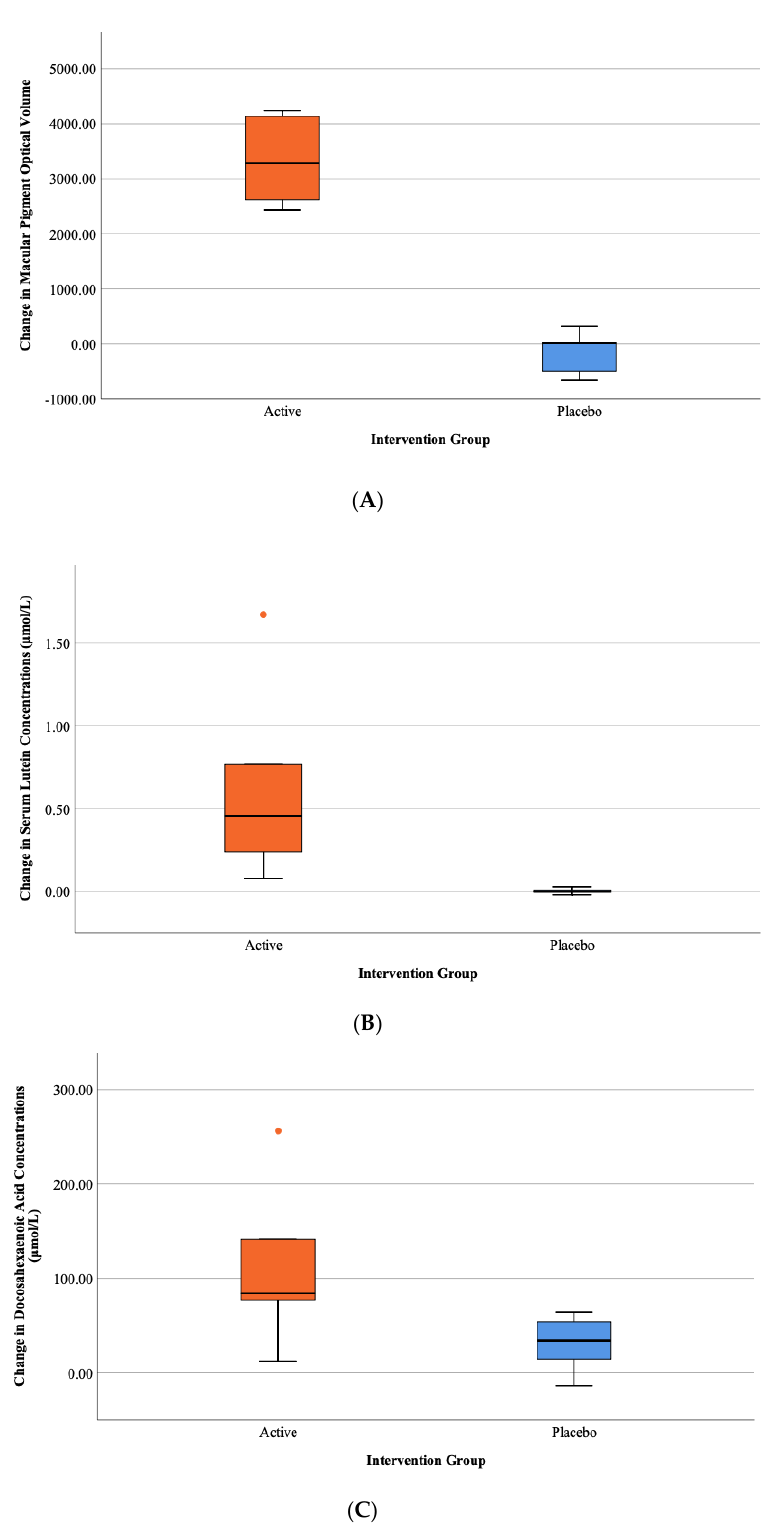
Figure 2. ( A ) Box plots illustrating change in MPOV over 12 months for active and placebo intervention groups. ( B ) Box plot illustrating change in serum lutein over 12 months for active and placebo intervention groups. ( C ) Box plot illustrating change in plasma DHA over 12 months for active and placebo intervention groups.